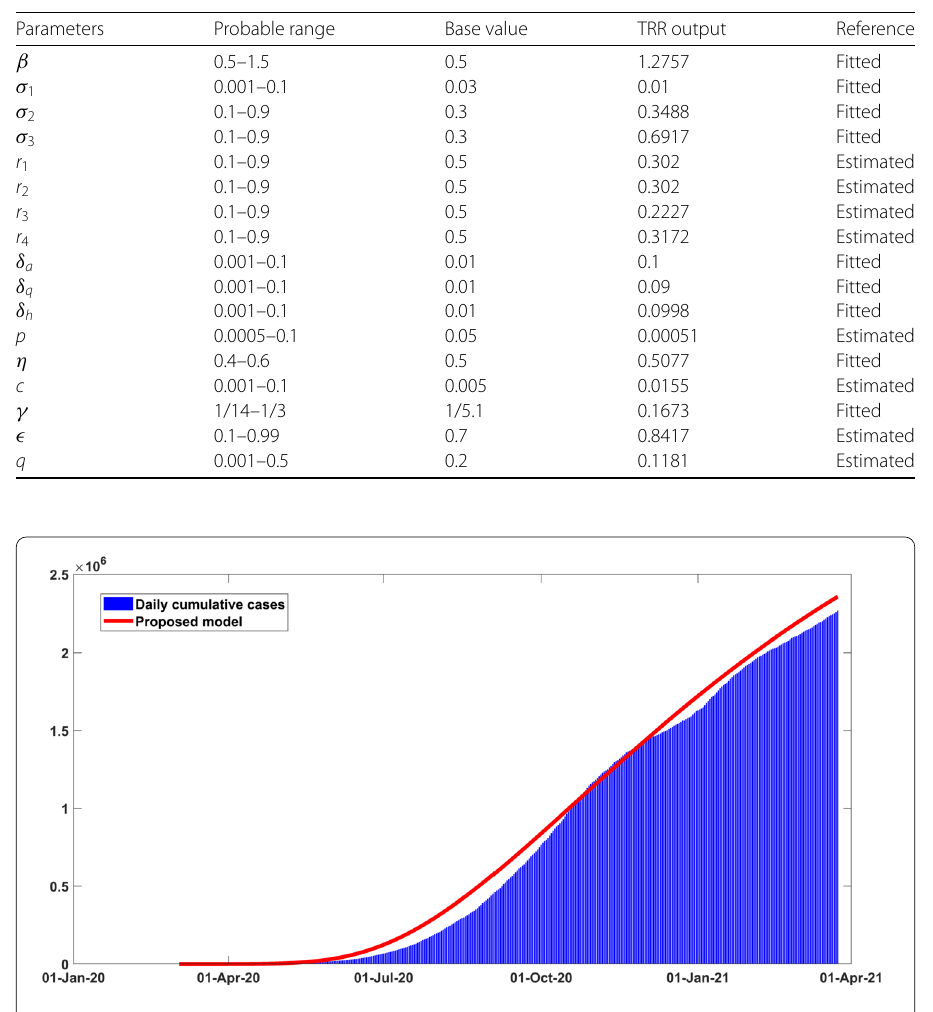
Figure 3 Output of the model performance fitting for cumulative cases of infection in Argentina from March 03, 2020 to March 29,